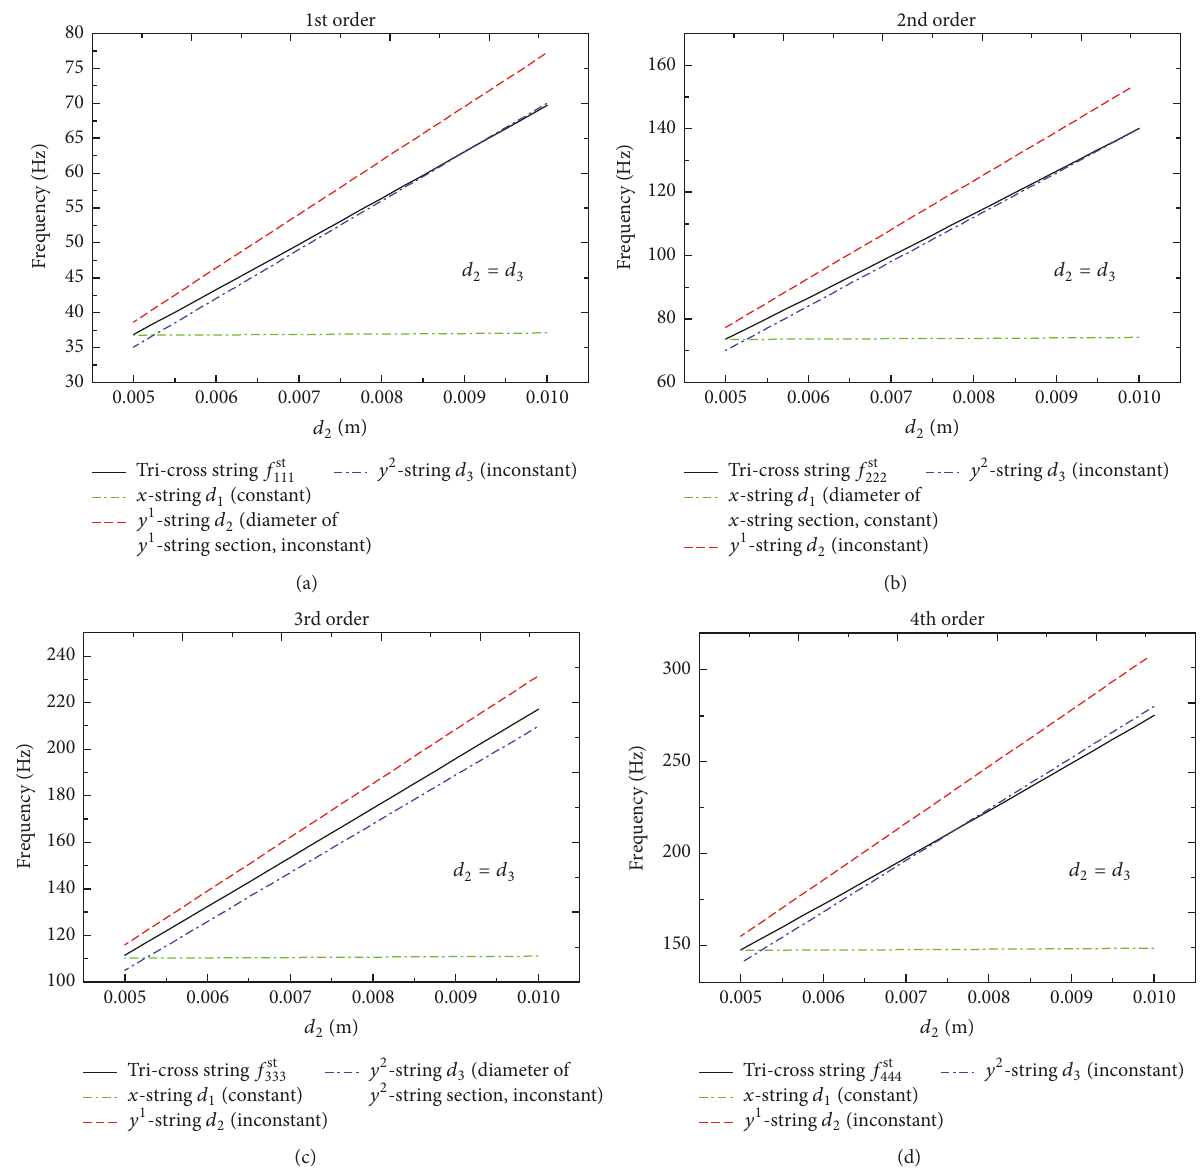
Figure 6: The influence of diameters of two constituent strings on the first four frequencies of the strings: (a) the first mode 𝑓 st 111 , (b) the second mode 𝑓 st 222 , (c) the third mode 𝑓 st 333 , and (d) the fourth mode 𝑓 st 444 .